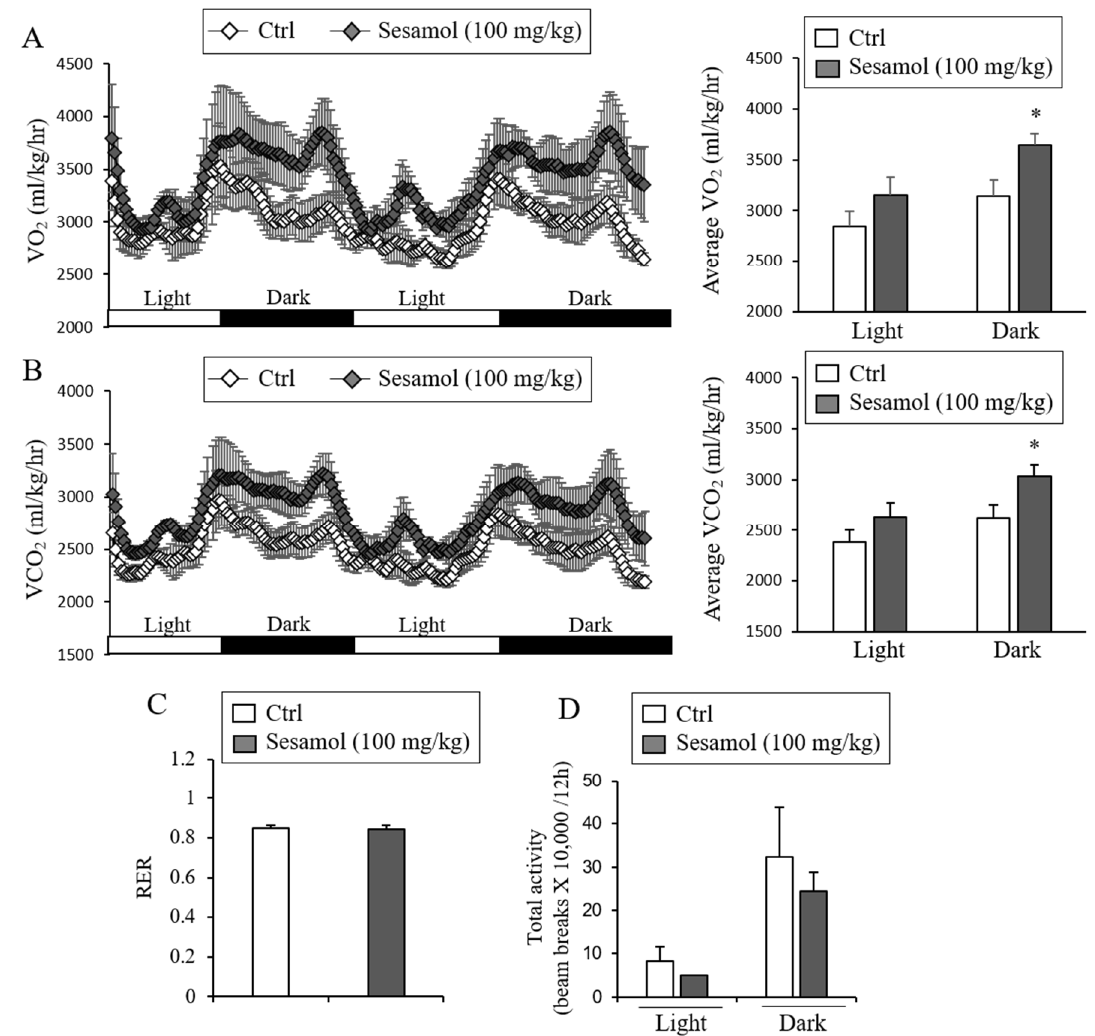
Figure 4. Oral administration of sesamol increases energy expenditure in mice. ( A , B ) Energy expenditure was evaluated by measurement of oxygen consumption and carbon dioxide production. O 2 consumption ( A ) and CO 2 production rates ( B ) of control- and sesamol-treated mice (100 mg / kg) were measured by indirect calorimetry using CLAMS after 3 weeks on the HFD ( n = 5 per group). Energy expenditure was measured at 3 weeks of treatments when body weights did not start to diverge. Bar graph (right panel) represents the average of O 2 consumption or CO 2 production in each group. ( C ) Respiratory exchange ratio (RER) of the control- and sesamol-treated mice ( n = 5 per group). ( D ) Total physical activities of control- and sesamol-treated mice ( n = 5 per group). Data represent mean ± s.e.m. and statistically significant differences between the control- and sesamol-treated mice were determined by Student’s t -test (* p < 0.05).